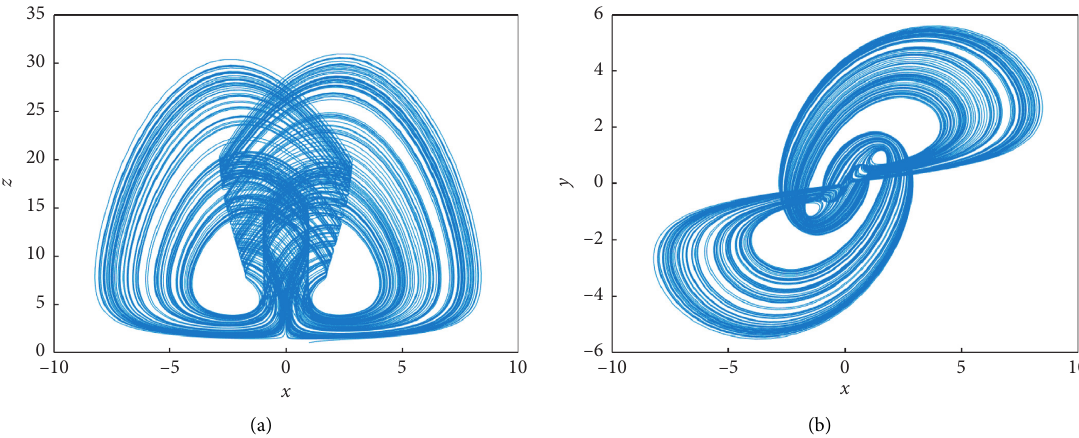
Figure 17: Phase portraits of the fractional system with c � 3 . 5 and α � 0 . 95.